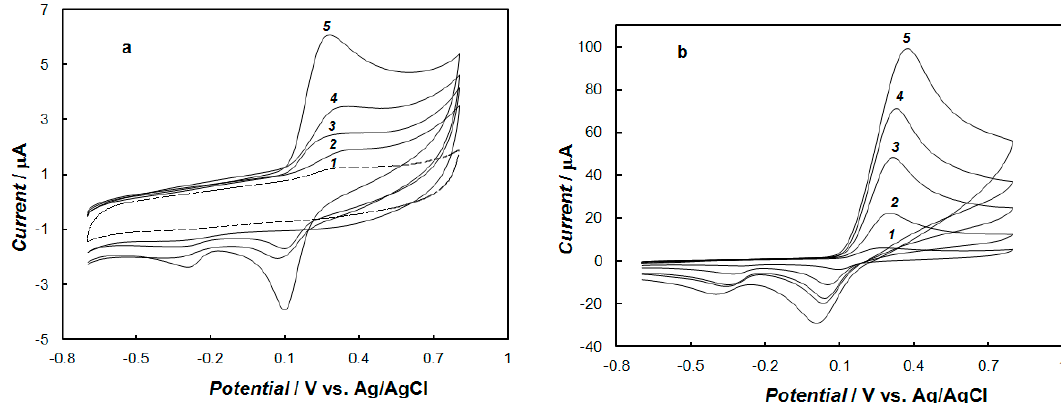
Figure 6. Cyclic voltammograms recorded at the gold electrode modified with the polypyrrole— MCM-48 nanocomposite in 0.1 M of phosphate buffer solution (pH = 7.4) containing dopamine with concentrations: (a) 0 mM (curve 1 ), 0.01 mM (curve 2 ), 0.05 mM (curve 3 ), 0.1 mM (curve 4 ), and 0.2 mM (curve 5 ); (b) 0.5 mM (curve 1 ), 1 mM (curve 2 ), 3 mM (curve 3 ), 5 mM (curve 4 ), and 10 mM (curve 5 ). The potential sweep rate was 0.1 V s − 1 .